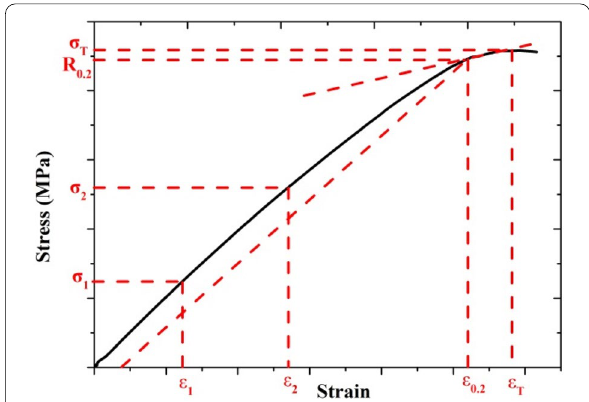
Fig. 1 Diagram used to determine conventional proportionality limit and yield